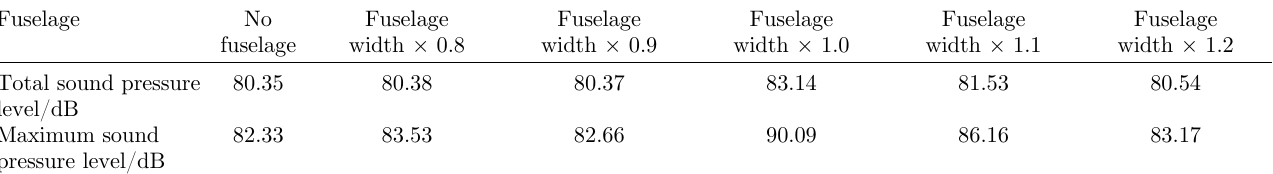
Figure 20. Scattering effect of fuselages with different width ratios. Table 6. Total and maximum SPL of helicopters with fuselages of different width ratios.